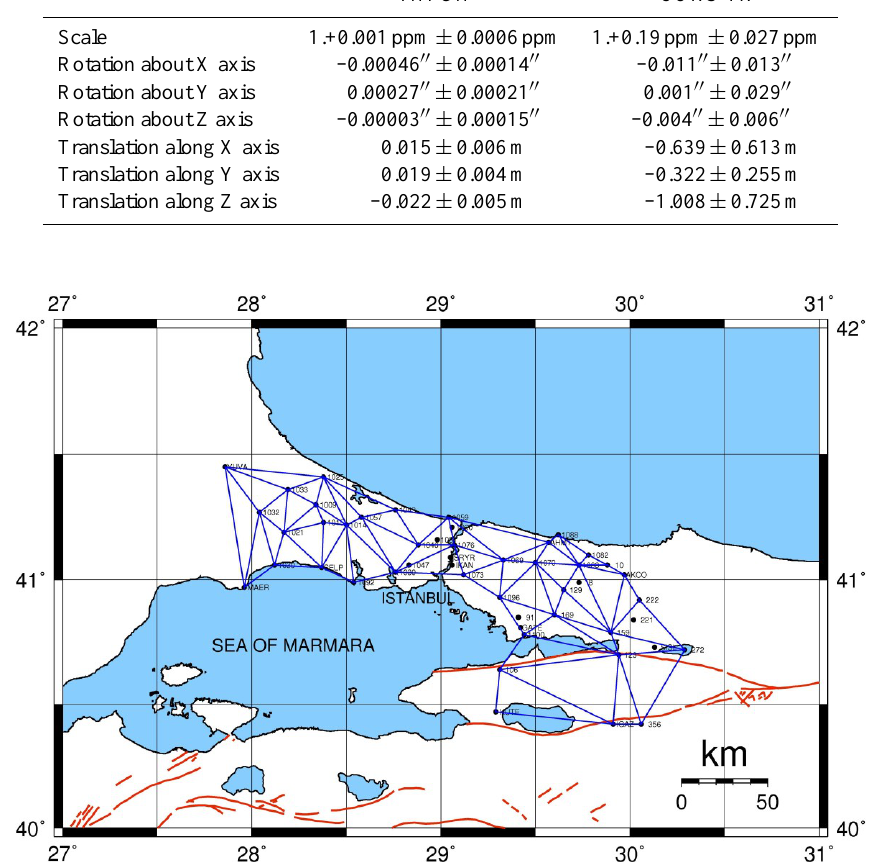
Fig. 2. Triangulation of the